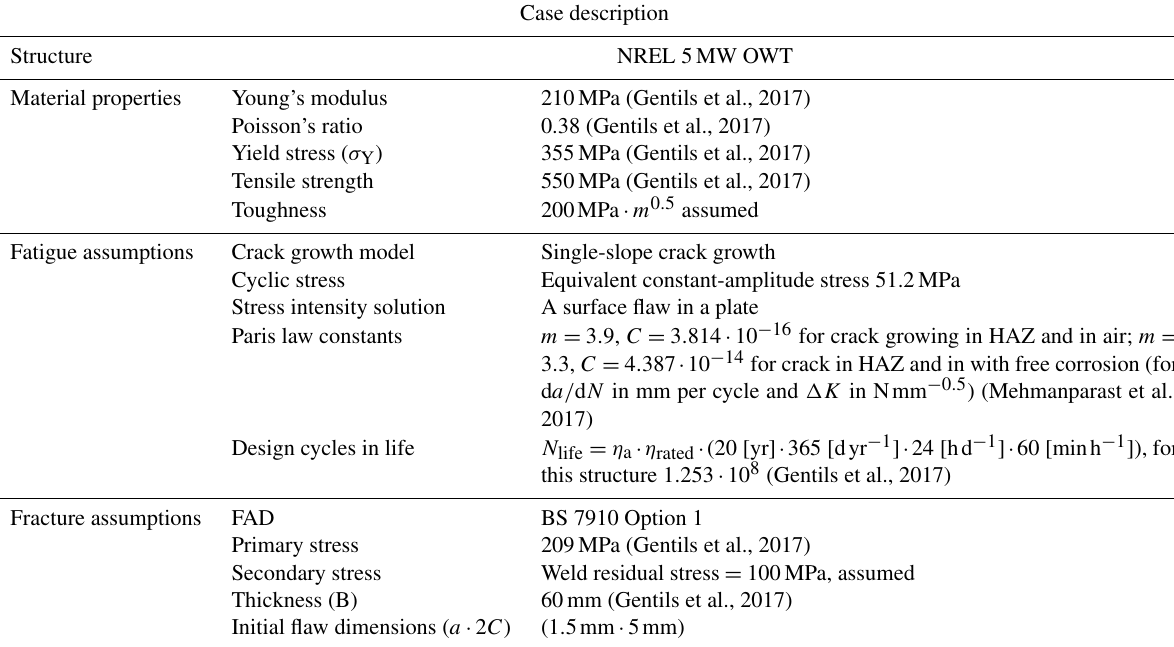
Table 5. Inputs for fatigue and fracture mechanics assessment.